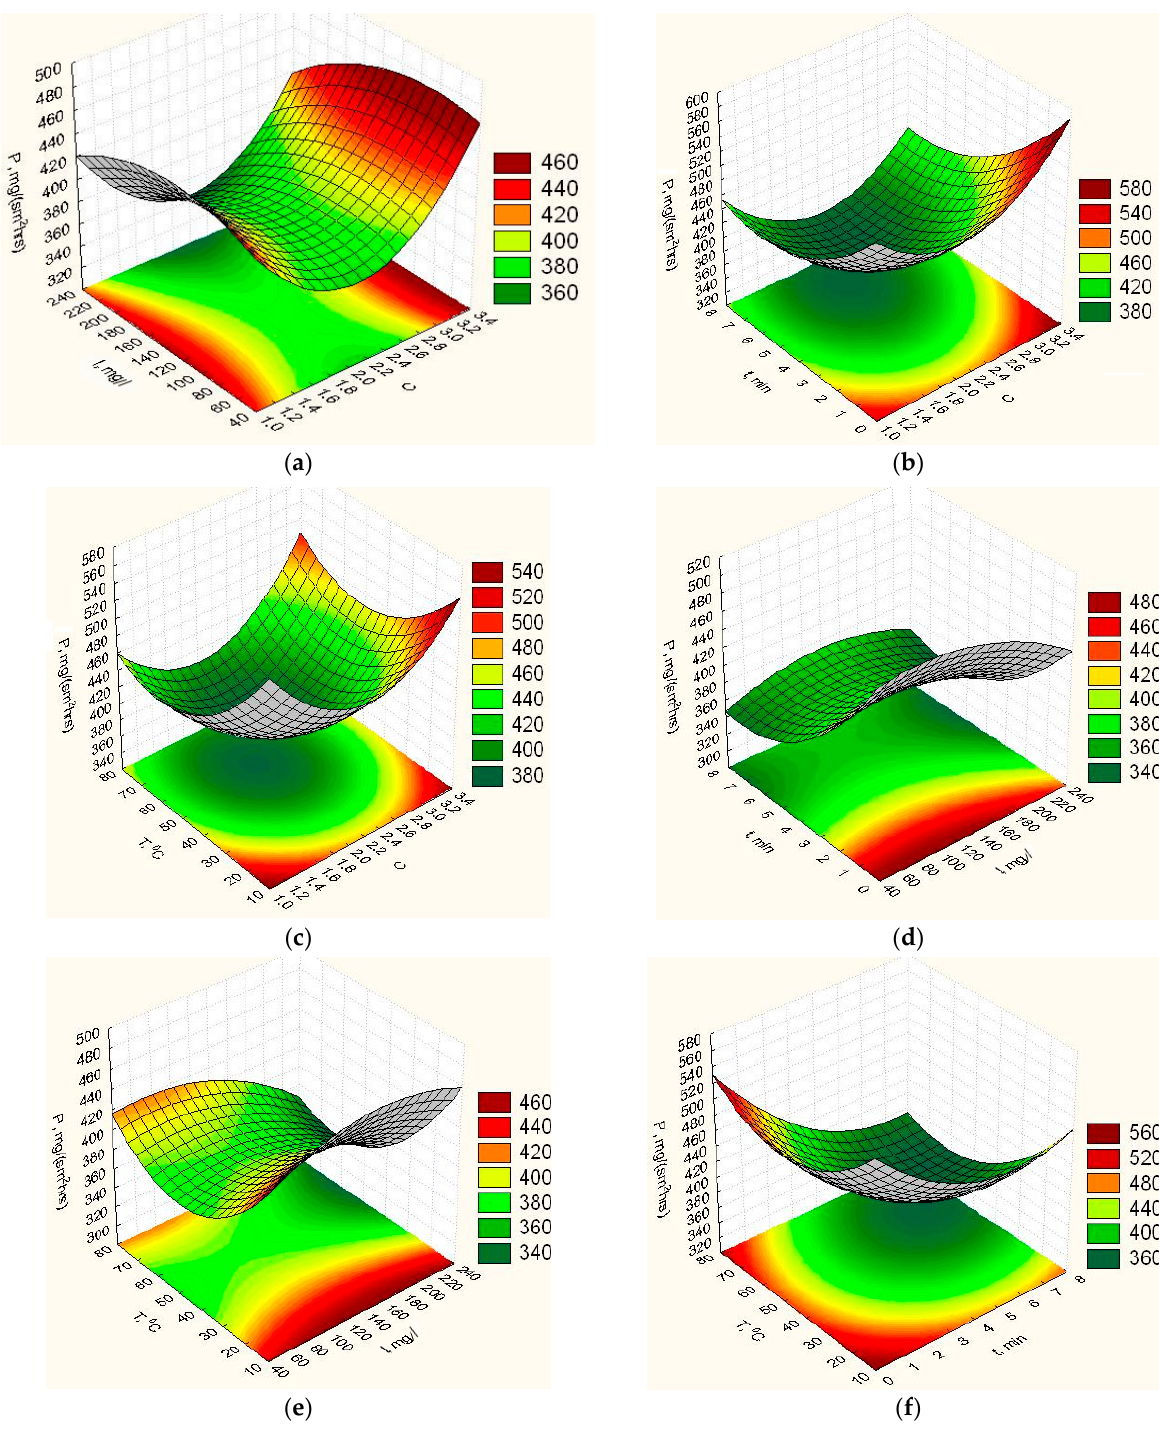
Figure 2. Response surfaces of dependence of the vapor permeability of the film on the composition and technological parameters of its manufacture: ( a )— C , I , t = 4 min, T = 46 ◦ C; ( b )— C , I = 140 mg/L, t , T = 46 ◦ C; ( c )— C , I = 140 mg/L, t = 4 min, T ; ( d )— C = 2.2, I , t , T = 46 ◦ C; ( e )— C = 2.2, I , t = 4 min, T ; ( f )— C = 2.2, I = 140 mg/L, t , T